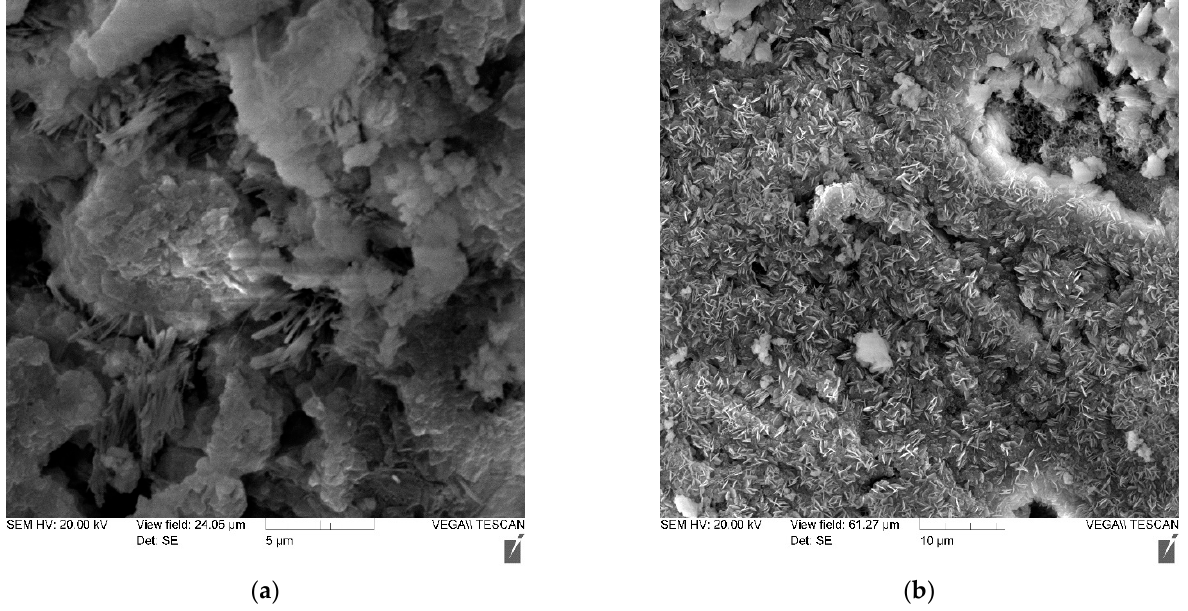
Figure 8. Photo of the microstructure of a cement stone without additives: ( a ) with 2000 × magnification ( b ) with 1000 × magnification.